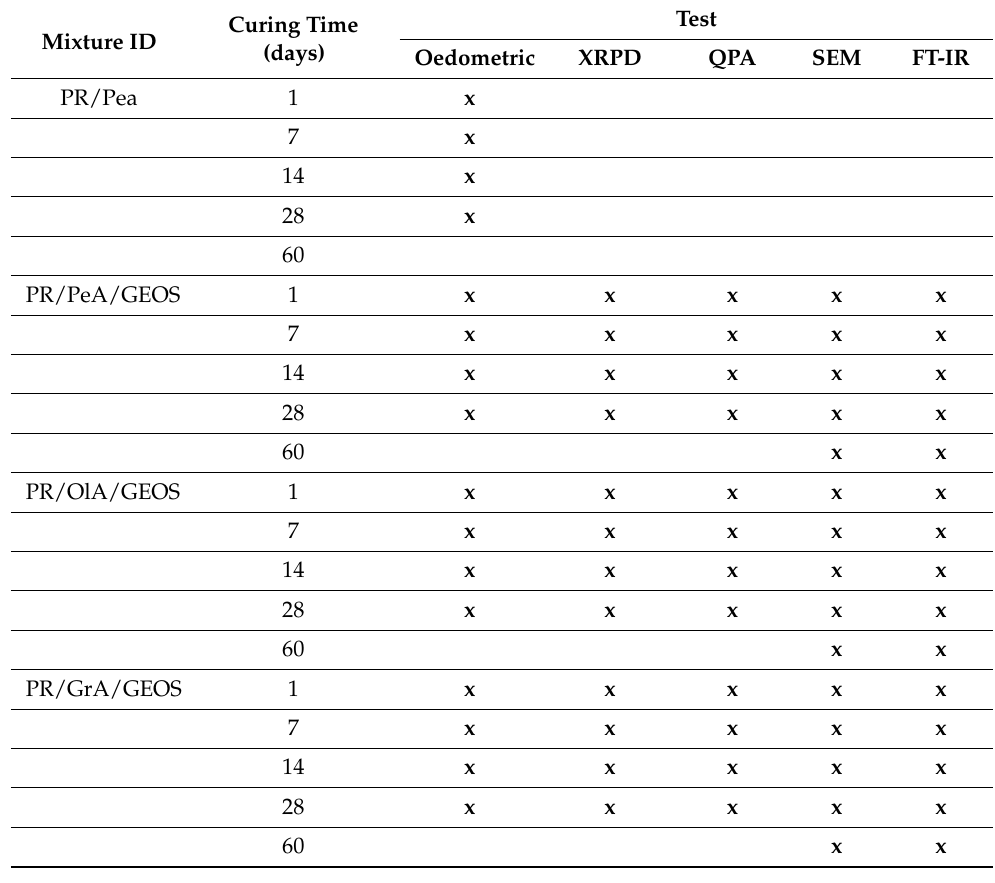
Table 9. Geotechnical and chemo-mineralogical analyses performed on mixtures at different curing times. See Table 8 for